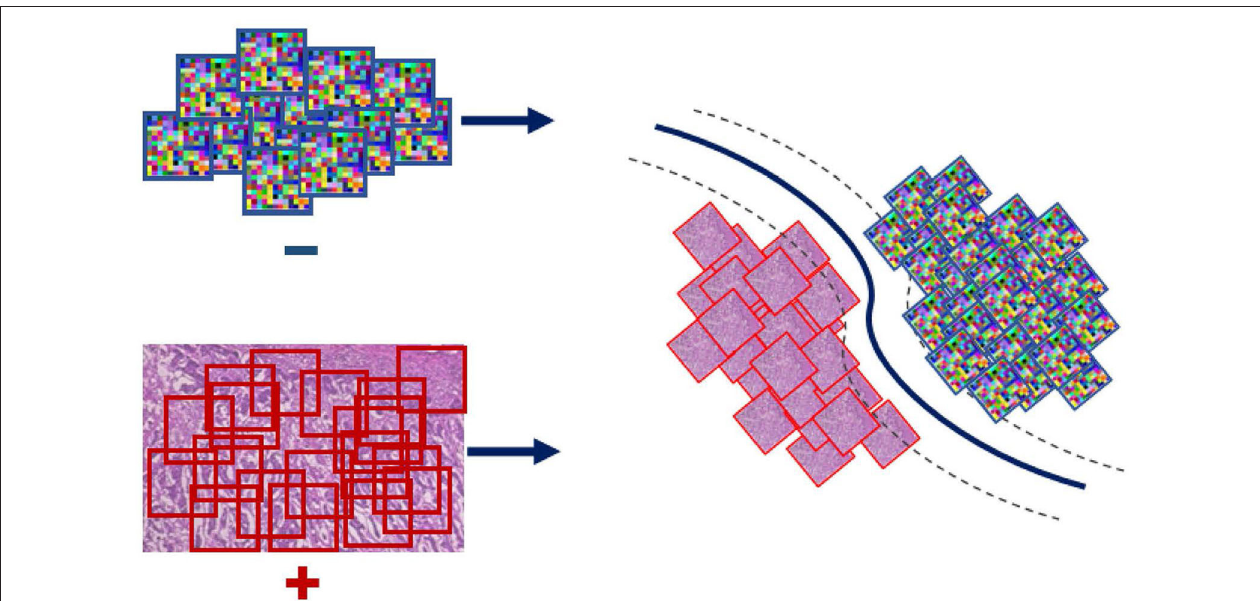
FIGURE 3 | WAID computation. Images are sub-sampled, and descriptors are computed for every derived patch. The WAID is computed as the vector containing the parameters of an SVM model computed in a multiple instance learning framework.